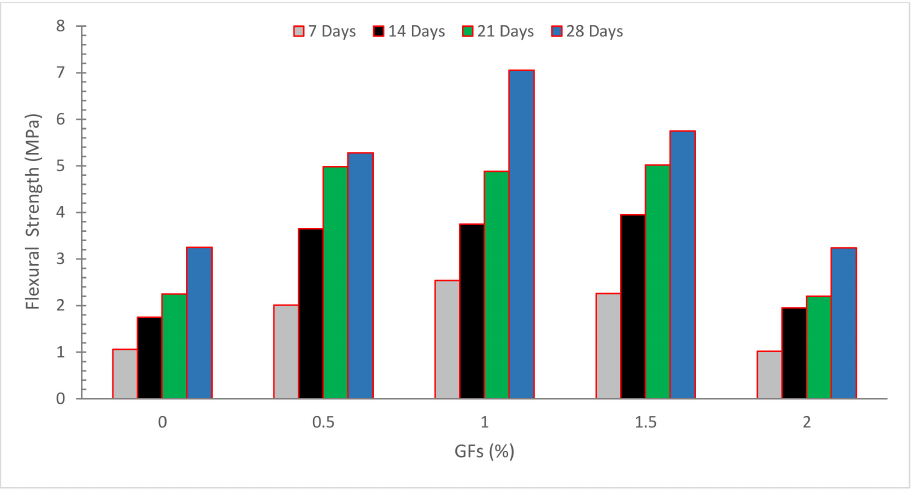
Figure 4. Flexural strength: Data source